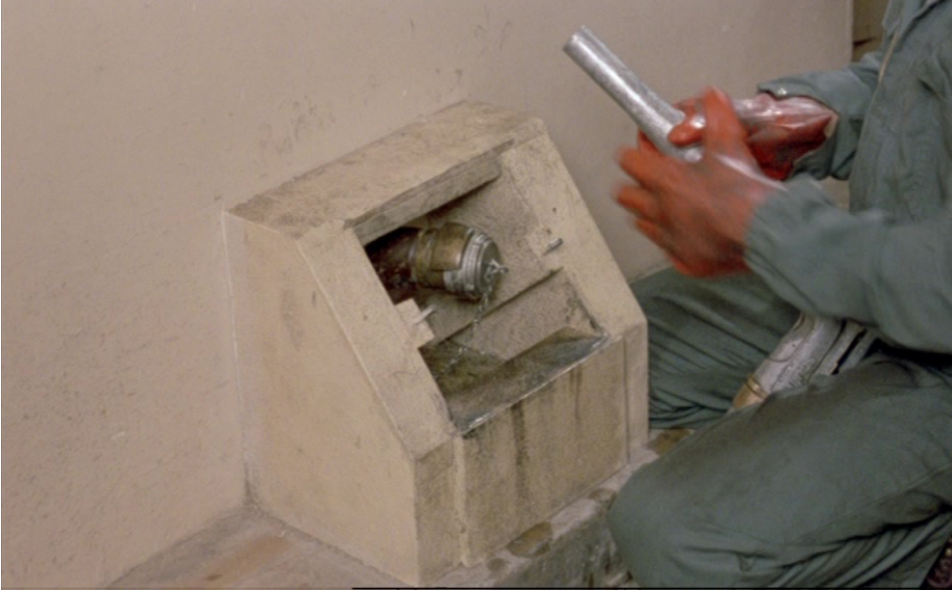
Figure 2: ‘See beings and things in their separate parts.’ Robert Bresson: still from